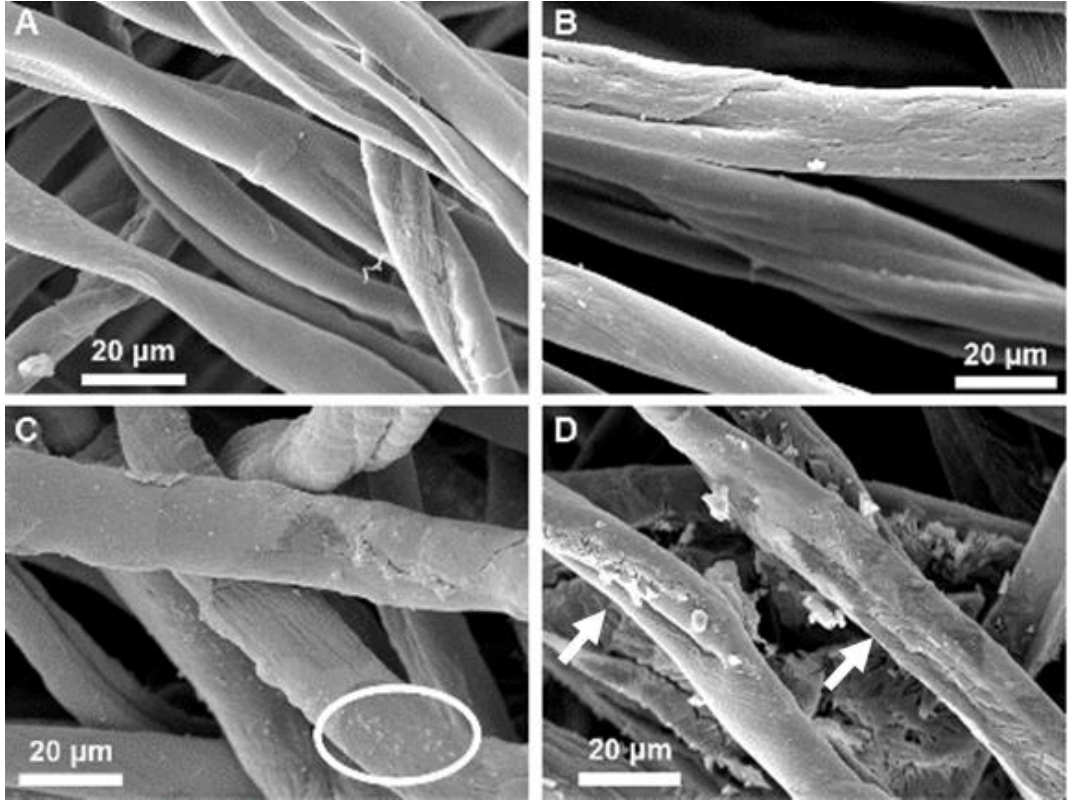
Figure 5. SEM images of ( A ) Untreated cotton nonwoven fabric; ( B ) Nonwoven fabric with adsorbed copper chloride; ( C ) Nonwoven fabric with copper nanoparticles; ( D ) Nonwoven fabric following ascorbic acid treatment. All images are shown at a 1200× magnification and with a 20 µm scale bar. The white circle in ( C ) indicates an area with Cu particles embedded in the fiber cuticle. Arrows in ( D ) point to surface damage following treatment with ascorbic acid.